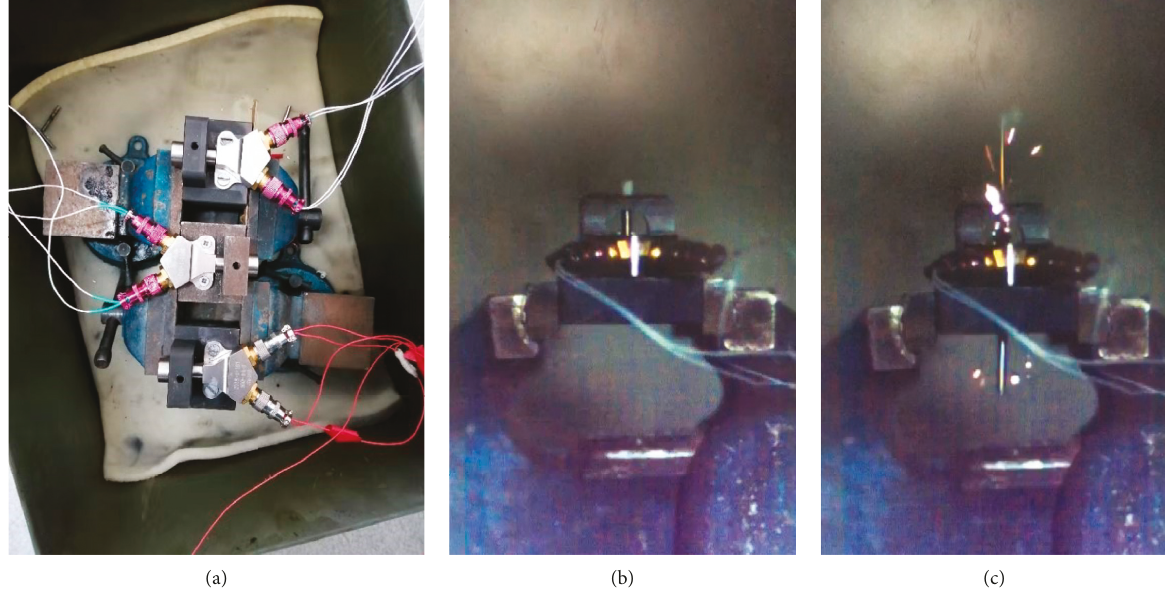
Figure 13: Pyrotechnic cutter test site. (a) Test site. (b) Before action. (c) After